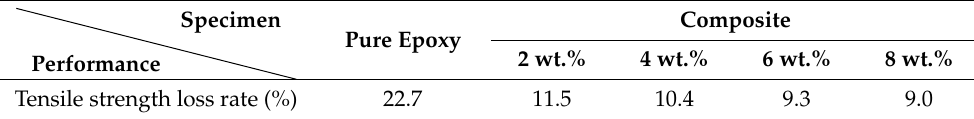
Table 2. Tensile strength loss rate of pure epoxy and composites after UV aging. Specimen Pure Epoxy Performance